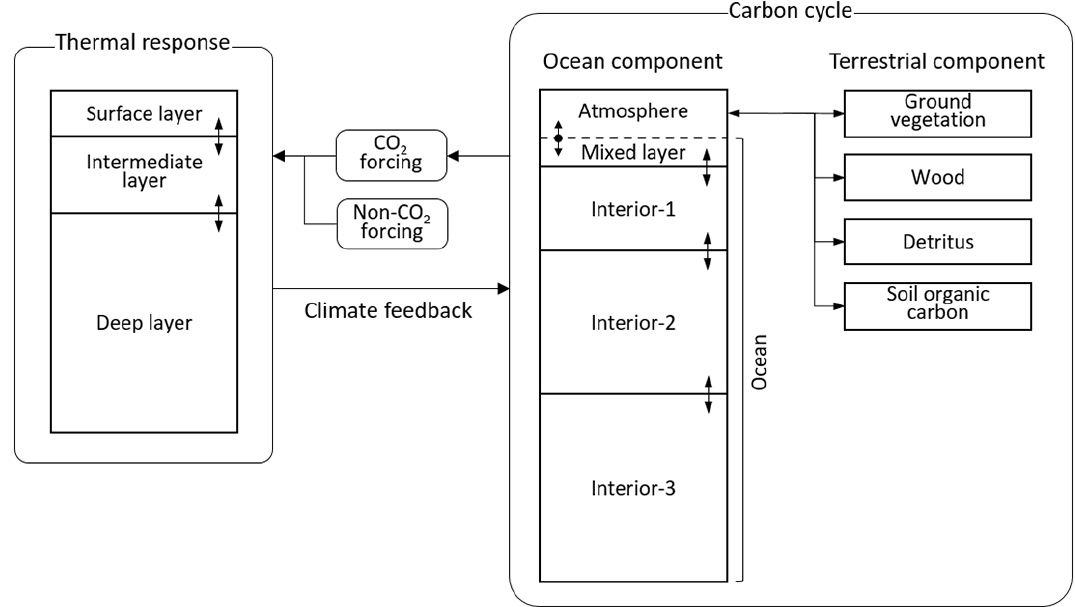
Figure 1. Schematic diagram of the box models equivalent to the MCE’s impulse response models. Bidirectional arrows represent heat and carbon fluxes within each module of the thermal response and carbon cycle. The two modules are connected through CO 2 forcing and climate feedback mechanisms.